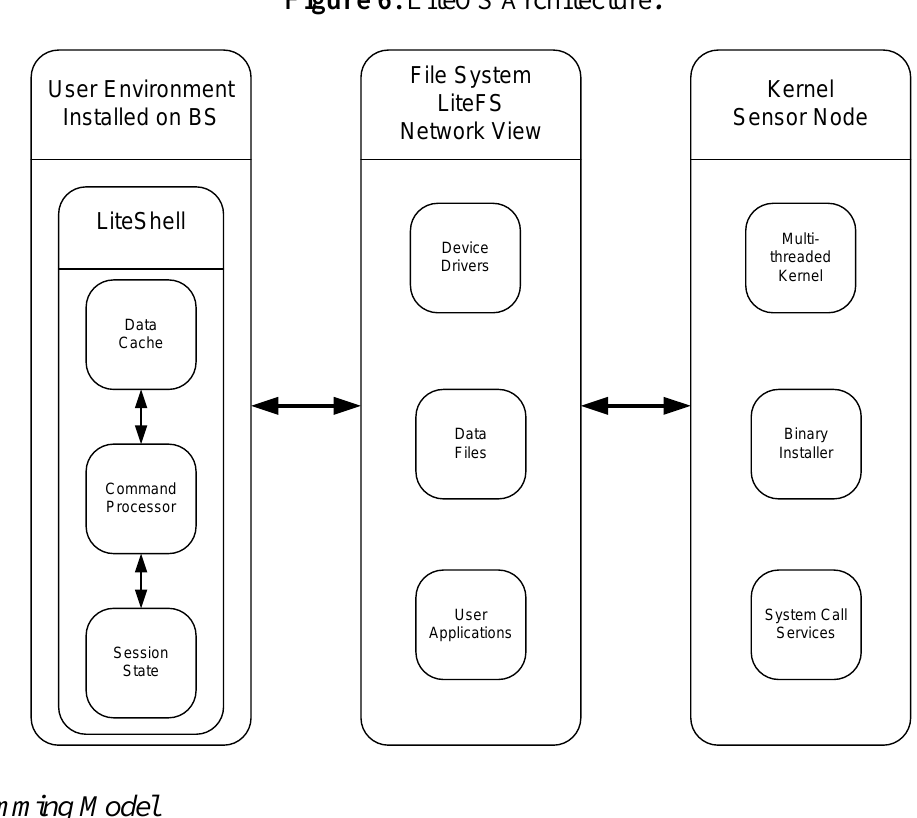
Figure 6. LiteOS Architecture